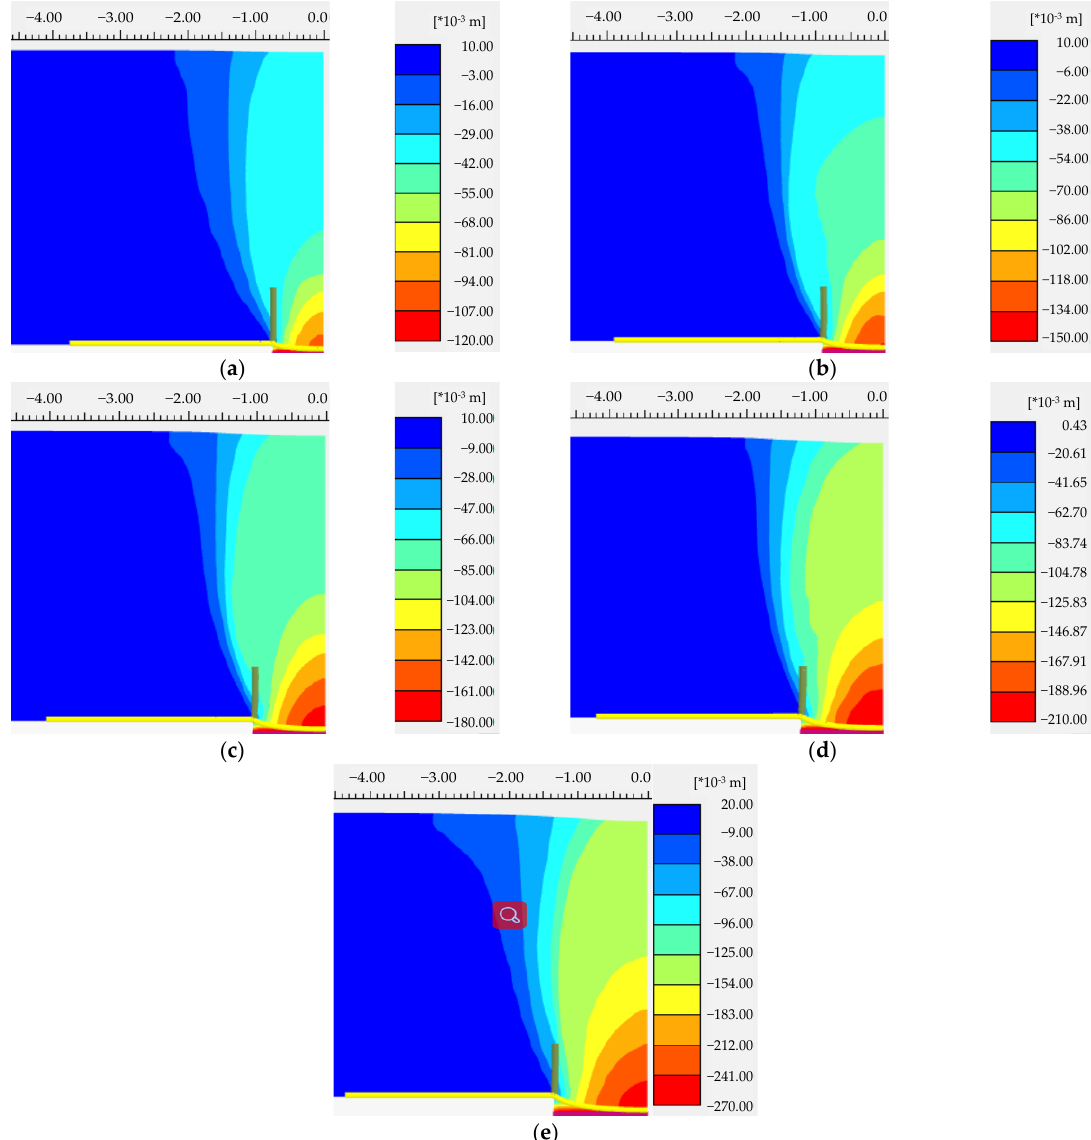
Figure 12. Vertical displacement cloud image of the soil at the final state of the subgrade collapse for the different subsidence widths: ( a ) L = 4.0 B ; ( b ) L = 3.33 B ; ( c ) L = 2.86 B ; ( d ) L = 2.50 B ; ( e ) L = 2.22 B .